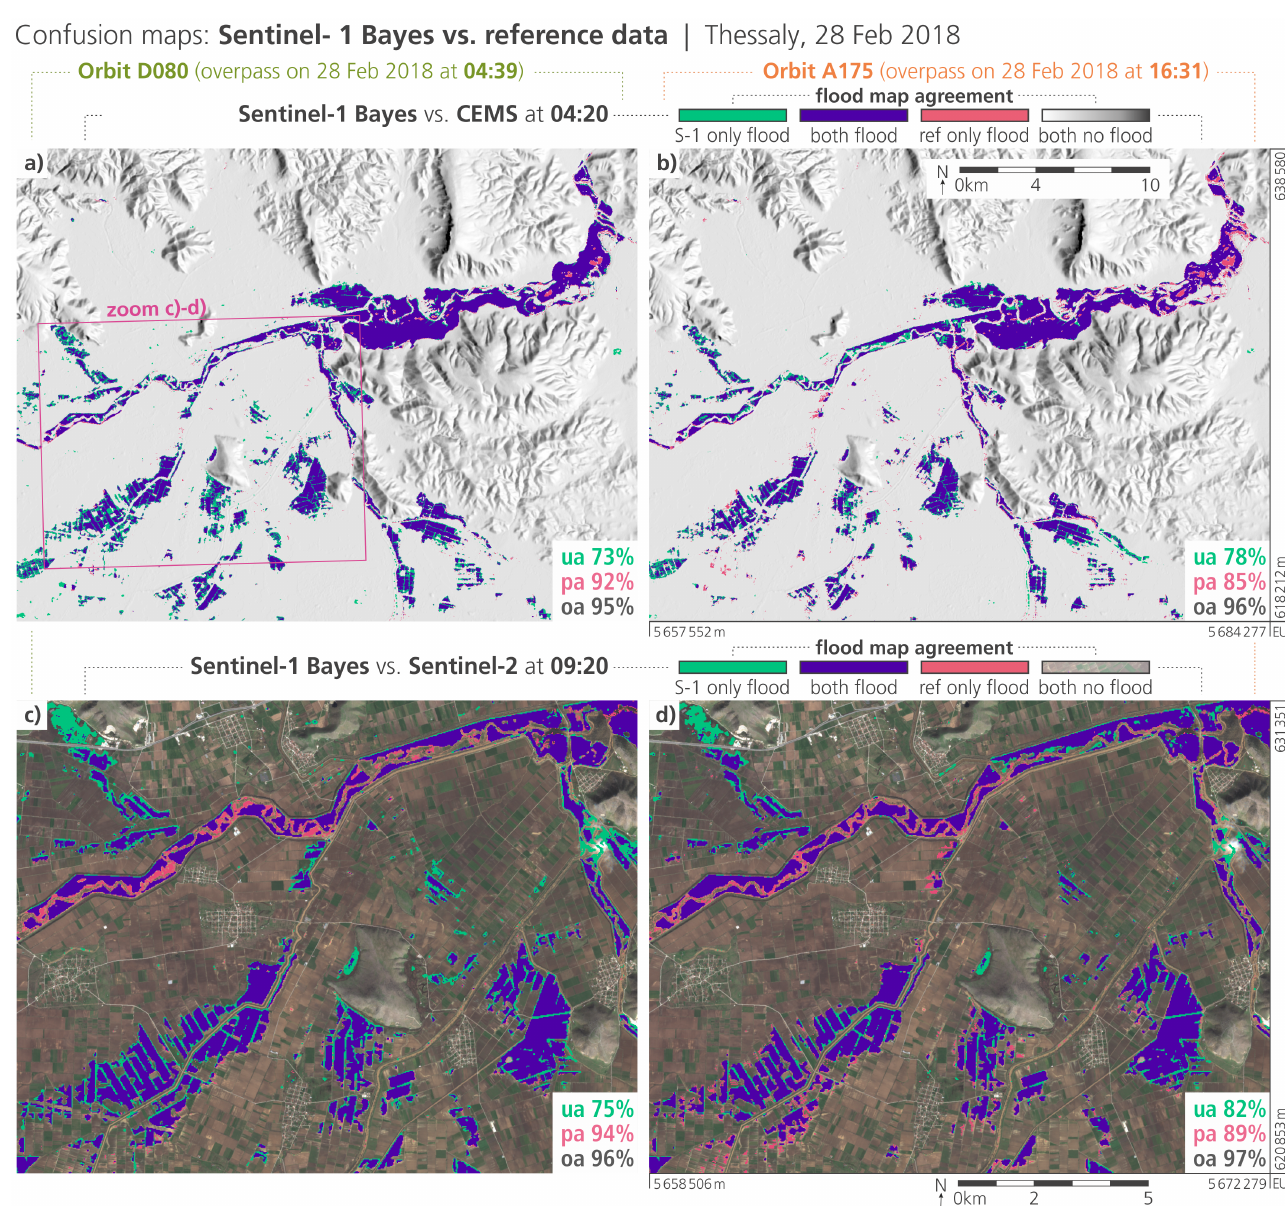
Figure 8. Confusion maps between the final Sentinel-1 Bayes flood mapping results and the reference flood maps, from ( a , b ) CEMS and ( c , d ) Sentinel-2, with respective User Accuracies (UA), Producer Accuracies (PA), and Overall Accuracies (OA). The lower panel shows zoomed-in maps to illustrate spatial detail, but provide accuracy metrics representing the complete